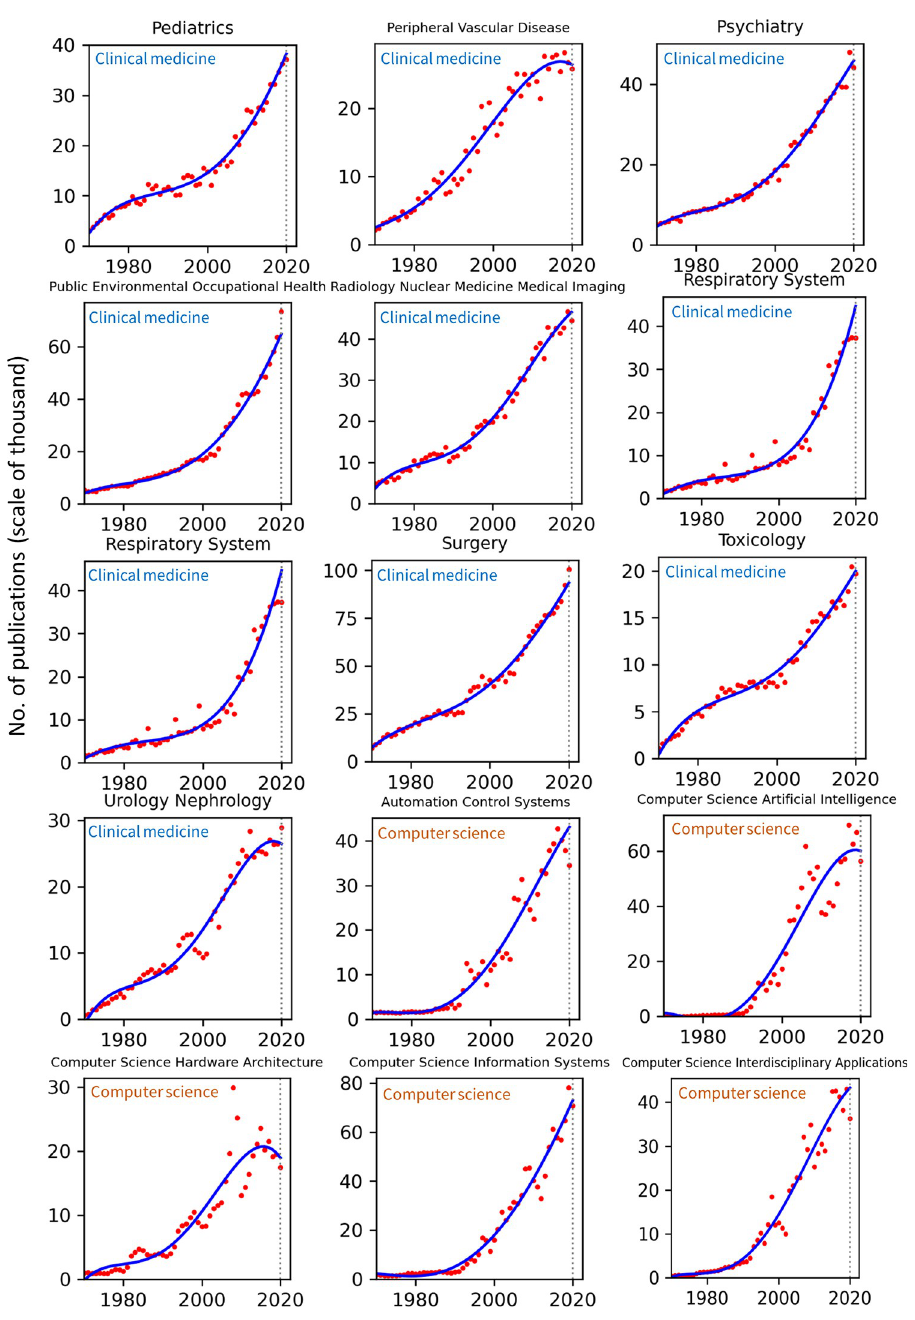
Fig 5. Temporal trends of research productivity in various scientific disciplines (part